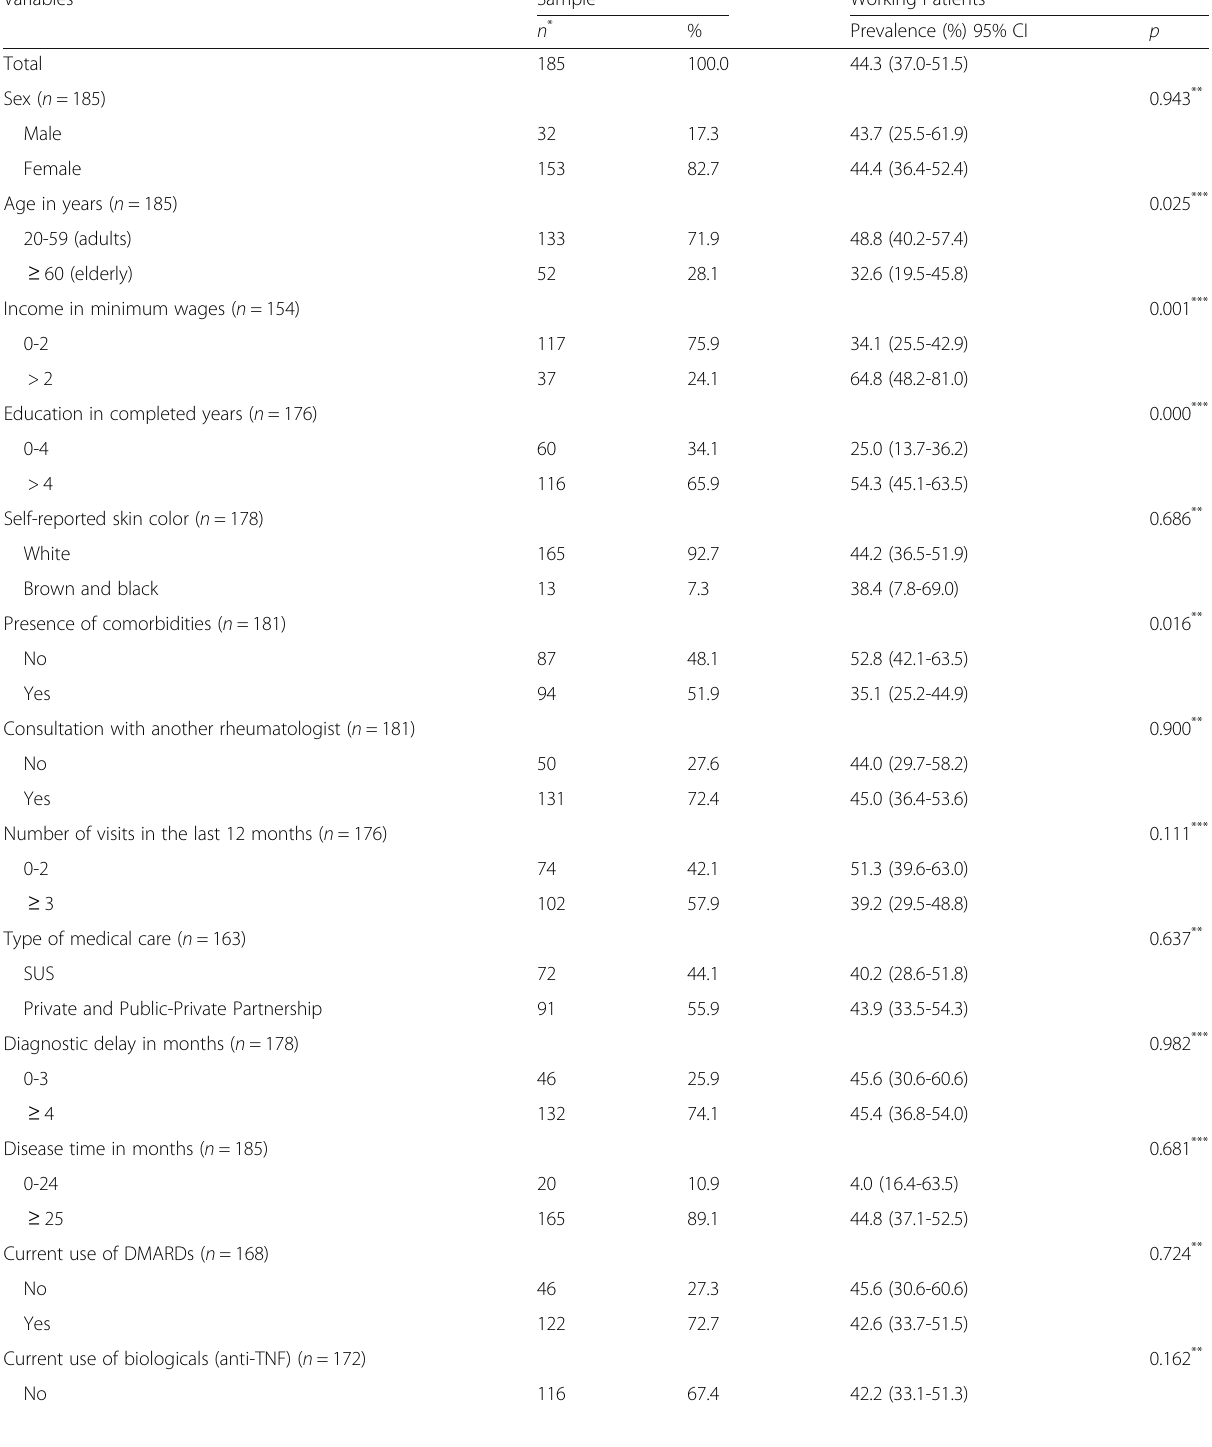
Table 1 Description of the sample and of the prevalence of working patients with rheumatoid arthritis in Blumenau, Santa Catarina state, Brazil, according to the independent variables,